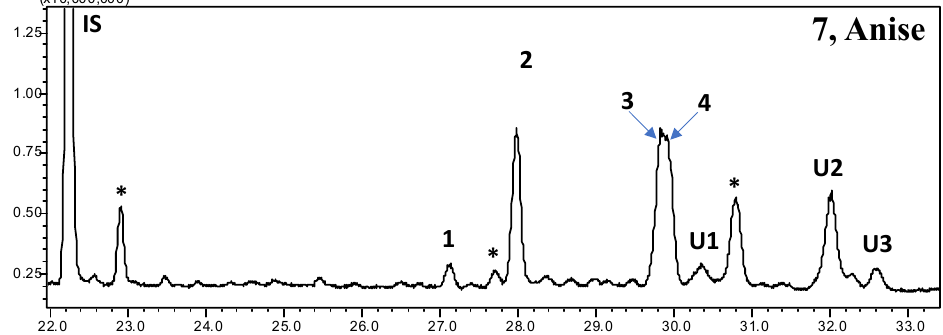
Figure 2. The gas chromatography (GC)- total ion chromatograms (TICs) of sterols identified from celery, caraway, fennel, and anise seeds (seed oil). The peak numbers are as follows: (1) campesterol, (2) stigmasterol, (3) β -sitosterol, and (4) α -spinasterol. IS: internal standard (epicoprosterol; 5 β -cholestan-3 α -ol; CAS 516-92-7); U: unidentified; * non-sterols compounds.